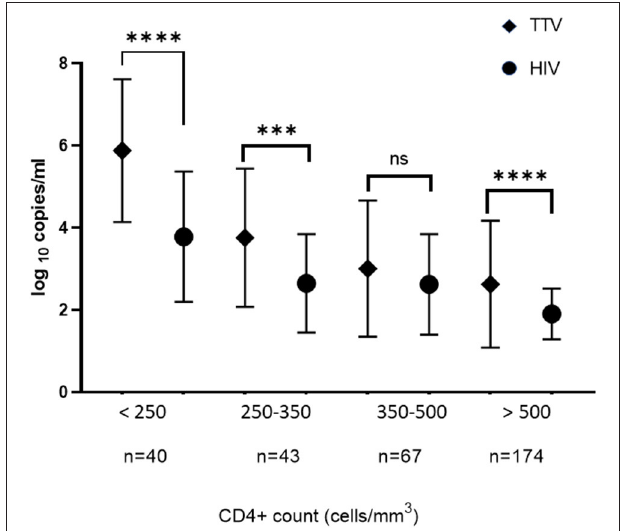
FIGURE 1 | Means of titers of TTV in the saliva and HIV in the circulation in relation to the CD4 + lymphocytes count from all subjects being treated with antiretroviral therapy. The TTV and HIV titers were proportionately increased when CD4 + count was decreased. The vertical bar indicates the Standard Deviation value of the titer of TTV and HIV in log 10 copies/ml. **** p < 0.0001; *** p < 0.0005; ns, statistically not